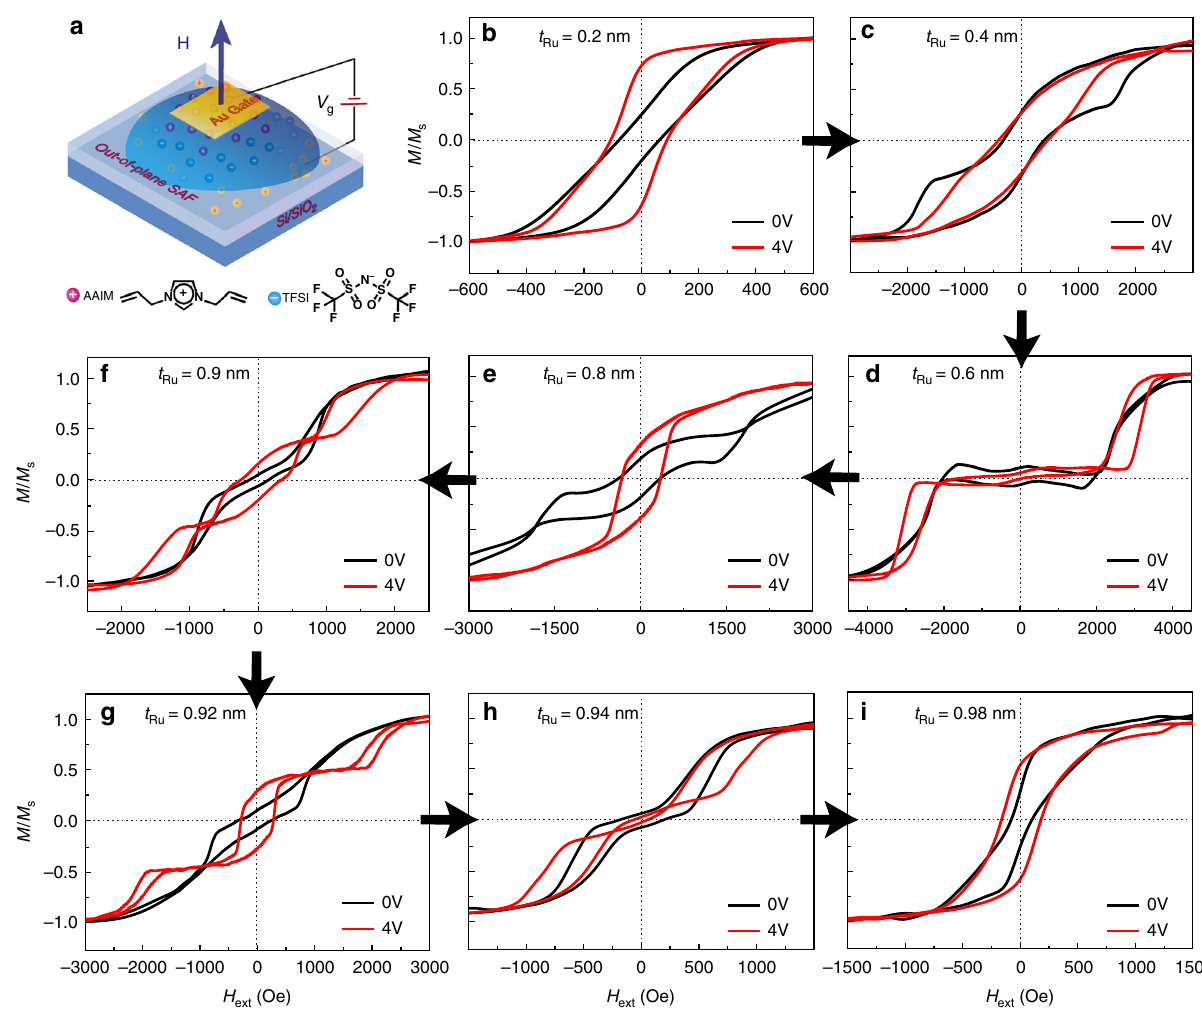
Fig. 3 Voltage control of RKKY interaction for out-of-plane con fi guration with (Pt/Co) 2 /Ru/(Co/Pt) 2 heterostructures. a Schematic of IL gating while the applying H- fi eld was along easy axis (out-of plane). b – i are the corresponding in-situ VSM tests for different Ru thickness at 0 and 4 V, respectively. Both the RKKY interaction and IL gating modi fi cation in Co/Pt system are very sensitive to t probably because that the surface modi fi cation becomes insensi- tive when the moments have strong parallel arrangements between the two FM sublayers 23,32 . The FM mode with a weaker IEC coupling can be affected by V g as shown in Fig. 2f. We will further discuss this IL gating-induced magnetism modi fi cation in Fig. 4.